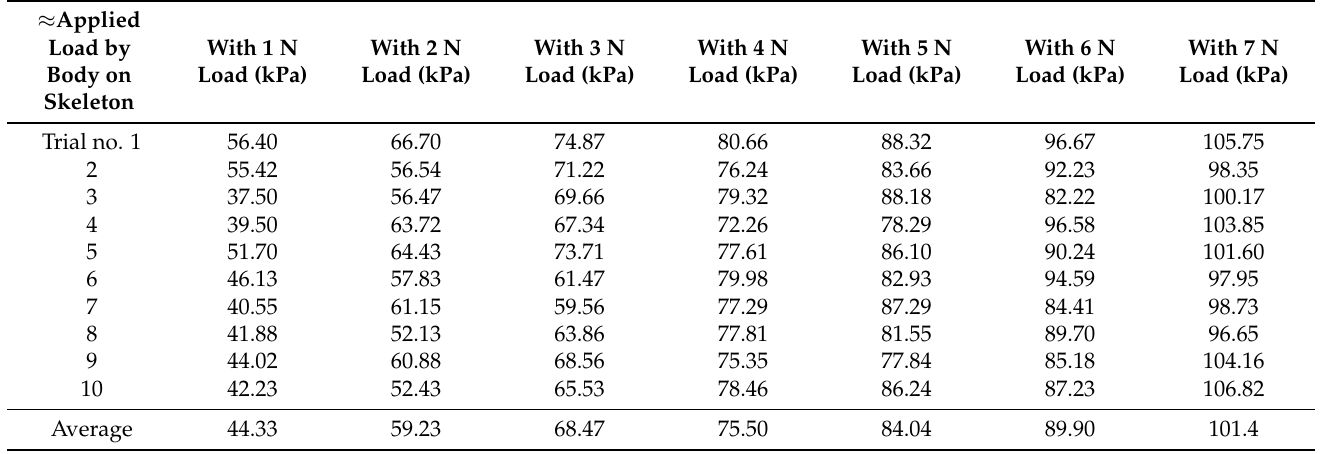
Table A1. Measured pressure (kPa) with respect to the applied load (N) by body on